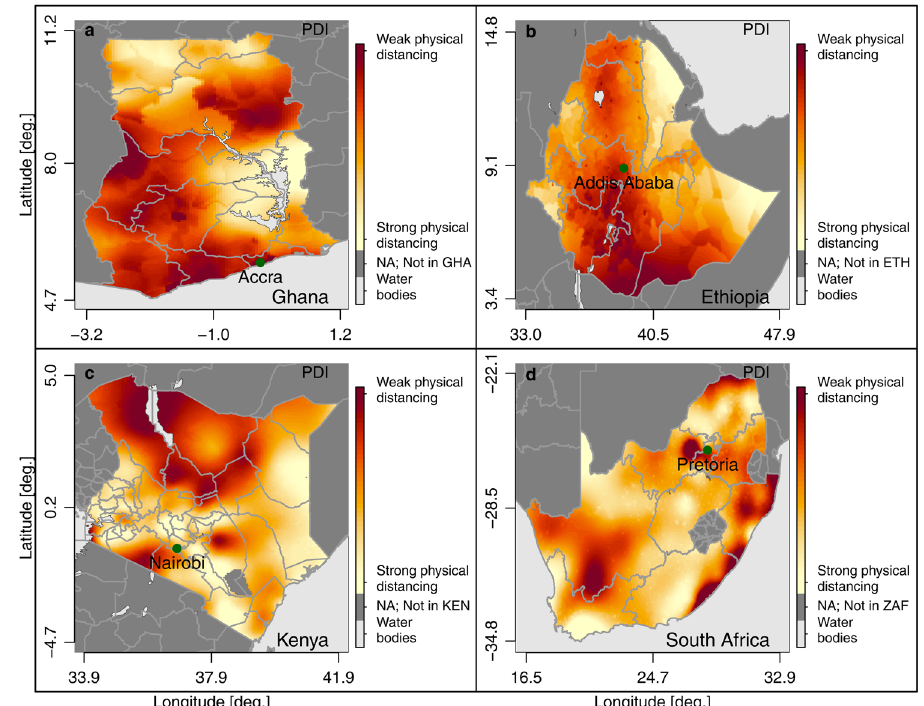
Fig. 2 PDI at 5 × 5 km level for Ghana, Ethiopia, Kenya, and South Africa. Estimates of the PDI at pixel level (5 × 5 km) for Ghana ( a ); Ethiopia ( b ); Kenya ( c ) and South Africa ( d ). Source: DHS and Center for International Earth Science Information Network — CIESIN — Columbia University 52 ; calculations by the authors.